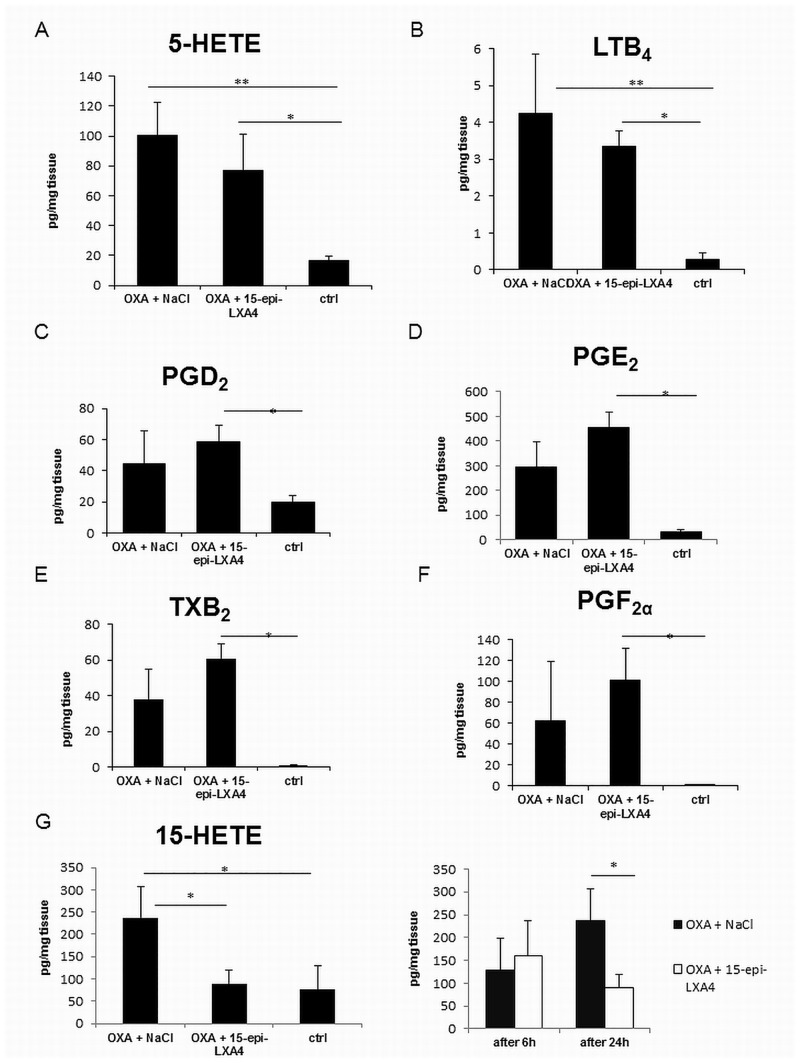
Levels of prostanoids, LTB4 and HETE at 24 h after application of 15-epi-LXA4 and NaCl.Levels of different prostanoids, products of the COX-pathway, like PGD2 (C), PGE2 (D), PGF2α (E) and TXB2(F), as well as products of the LOX-pathway, such as LTB4 (B), its precursor 5-HETE (A) and 15-HETE (G), were determined at 24 h after application of 15-epi-LXA4 or NaCl. Concentrations of 15-HETE were also compared 6 and 24 h after application of 15-epi-LXA4 or NaCl.